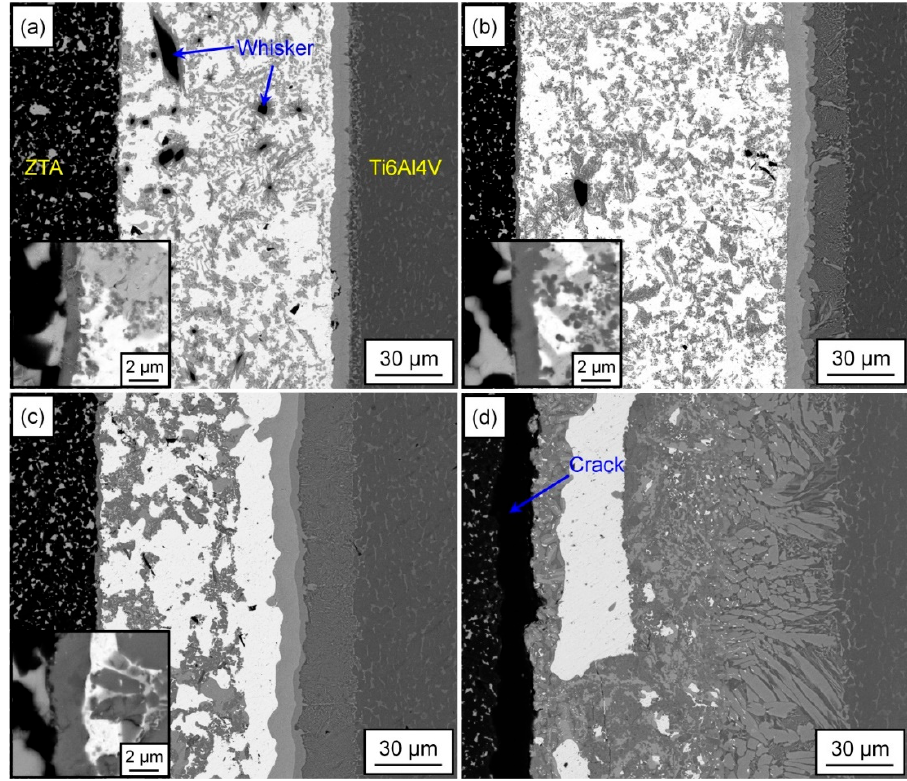
Figure 5. BSE SEM images of the ZTA/AgCu + ABOw/Ti6Al4V joints brazed at ( a ) 800 °C, ( b ) 850 °C, ( c ) 875 °C, and ( d ) 900 °C.